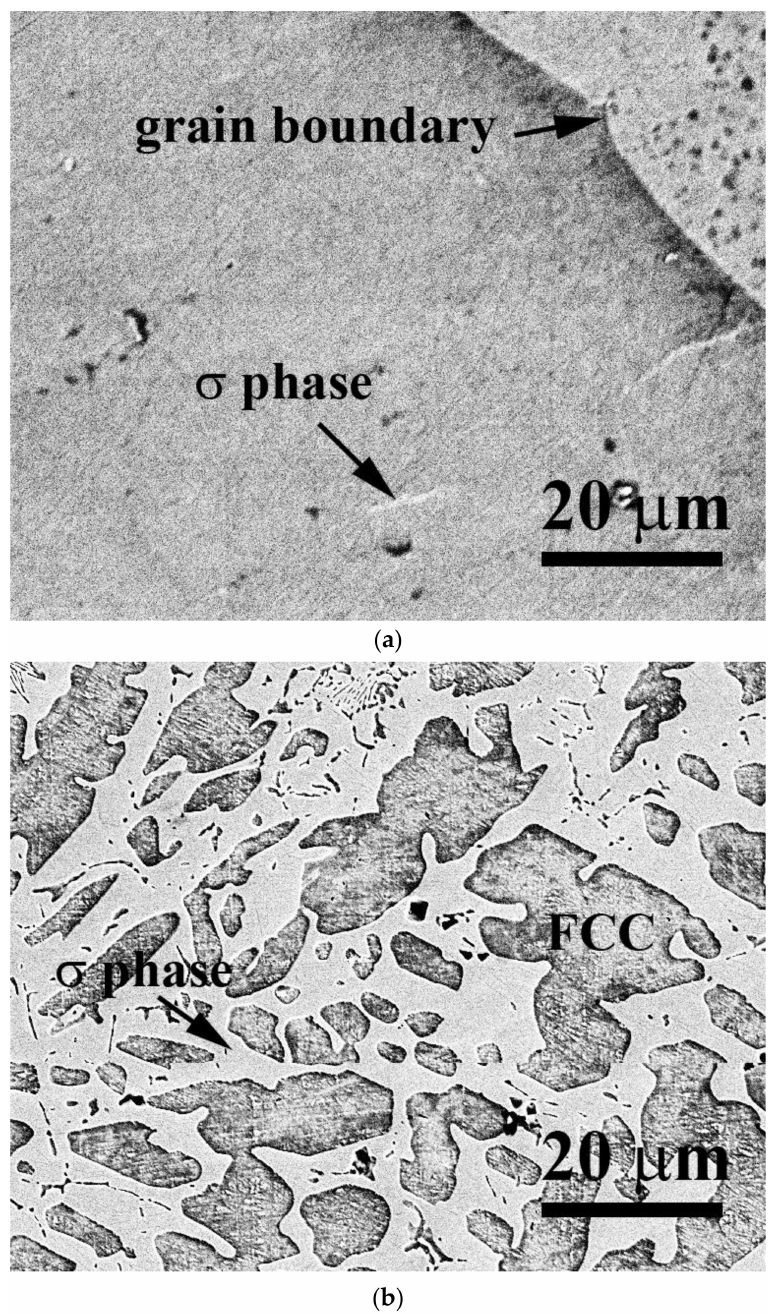
Figure 1. Microstructures of as-cast CrFeCoNiV x alloys: ( a ) CrFeCoNiV 0.5 alloy and ( b ) CrFeCoNiV